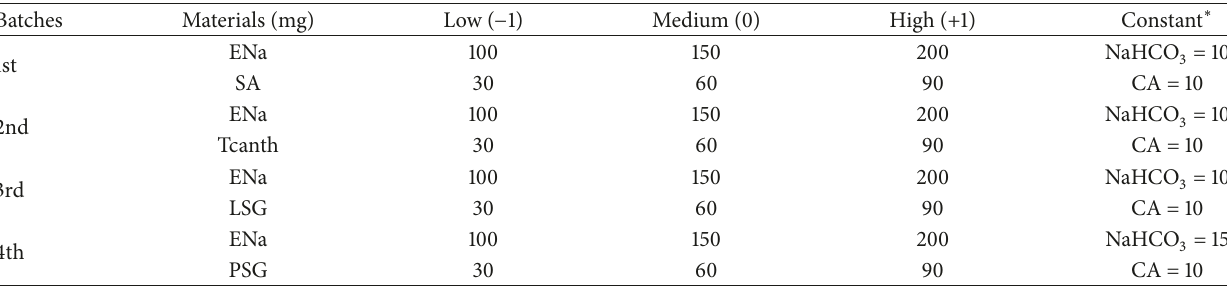
Table 1: Formulations design for RNT floats (drug